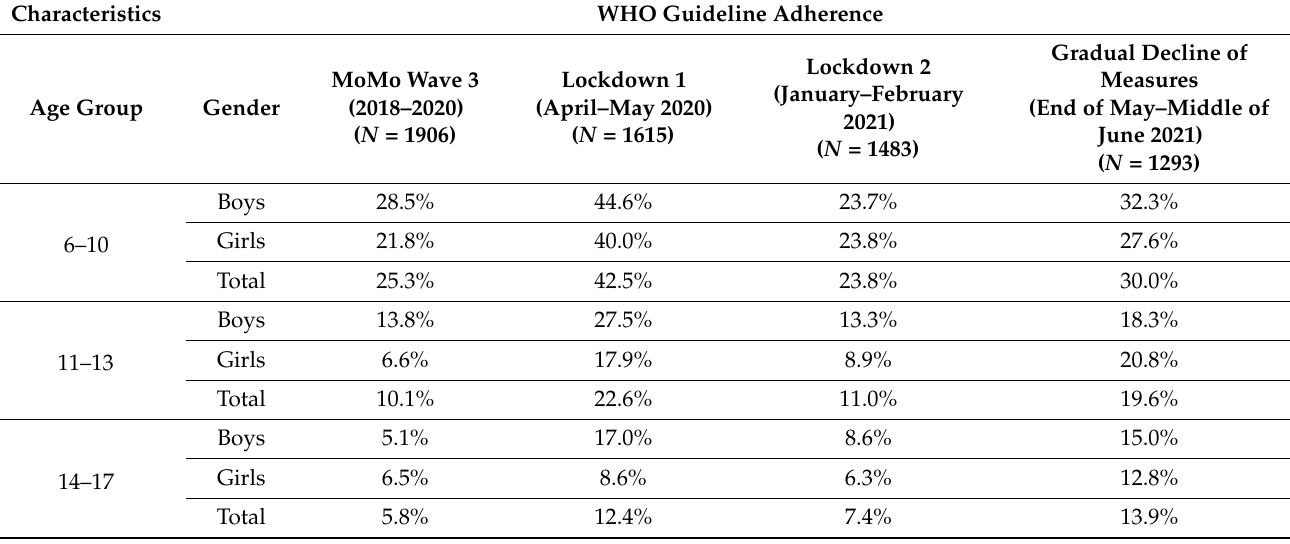
Table 3. Comparison of WHO guideline adherence in MoMo wave 3, lockdown 1, lockdown 2 [23], and phase of gradual decline of measures as a function of age and